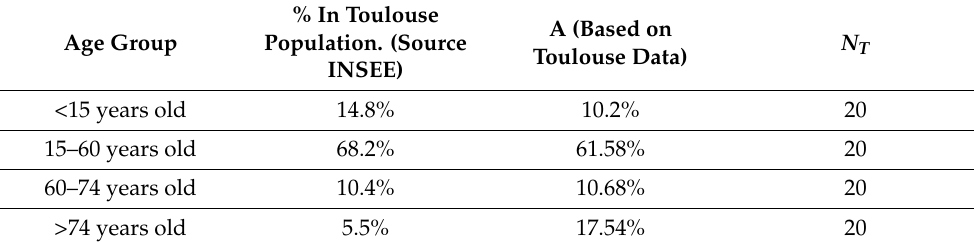
Table 1. Model initial